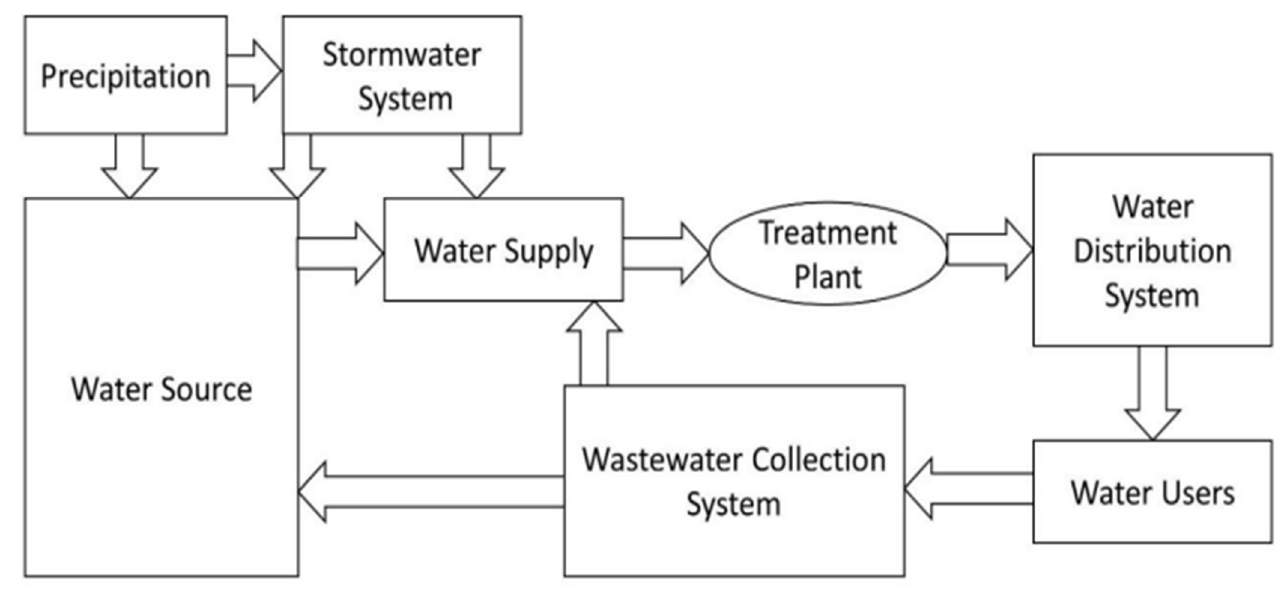
Figure 5. Water cycle in the urban region